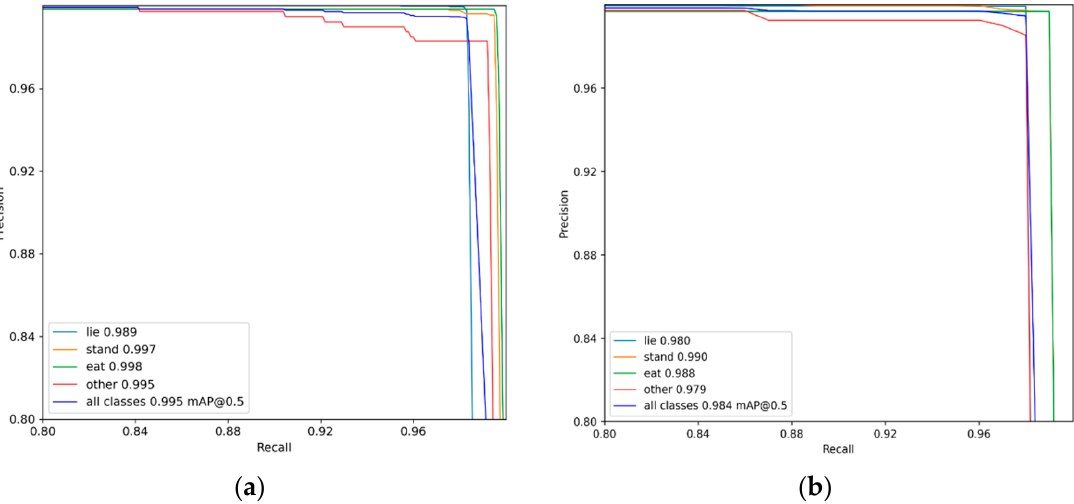
Figure 6. P–R curves of YOLO v5s and YOLOX-S models. ( a ) The P–R curve of YOLO v5s. ( b ) The P–R curve of YOLOX-S.